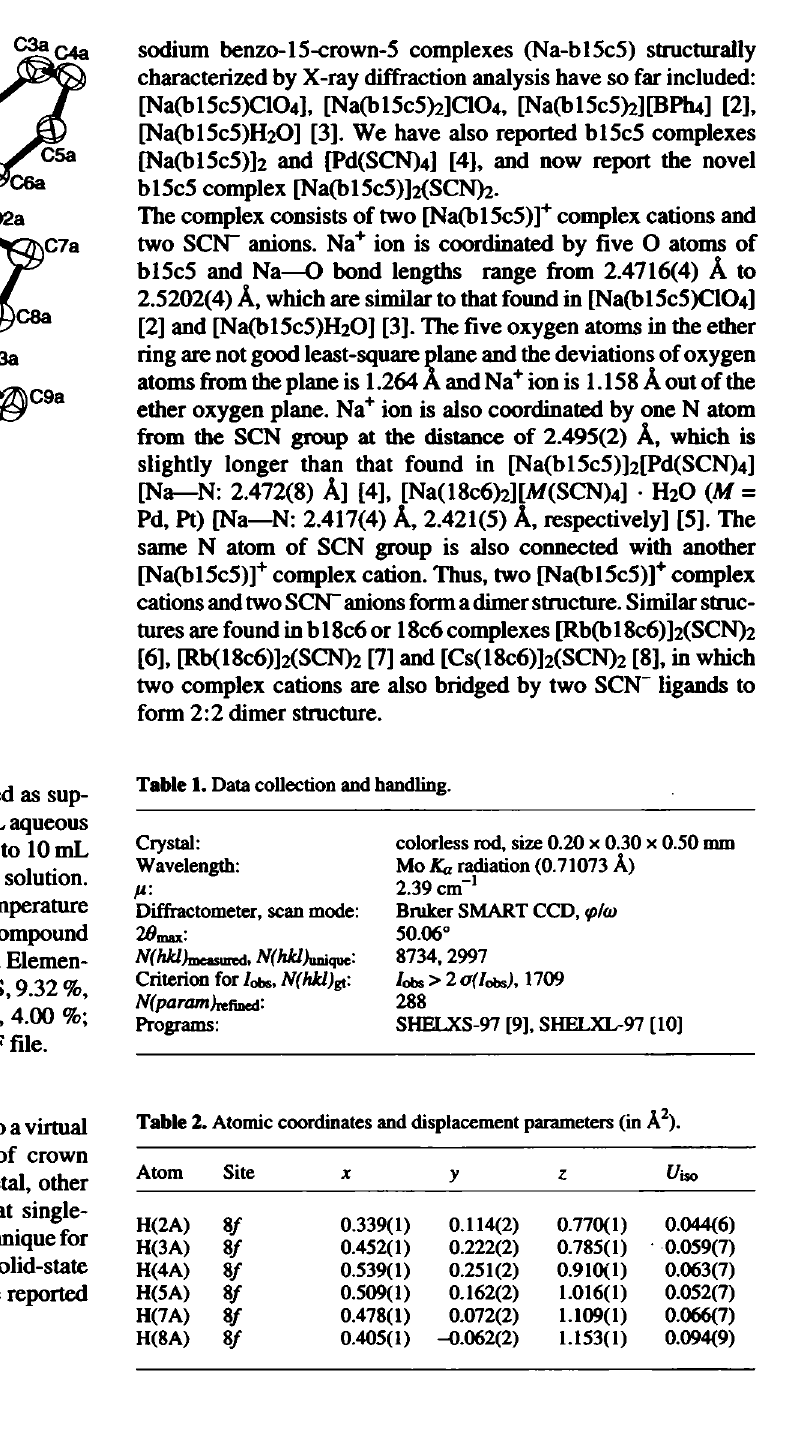
Table 2. Atomic coordinates and displacement parameters (in Â 2